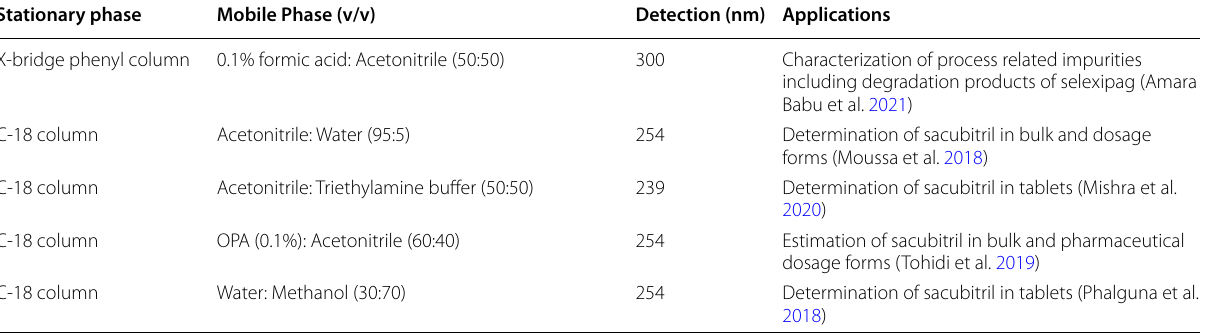
Table 3 HPLC methods for analysis of FDA-approved treatments for several cardiovascular illnesses from 2015 to June 2020 Stationary